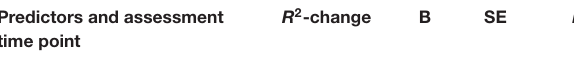
TABLE 4 | Results of the stepwise regressions of the motivation to change (ANSOCQ sum scores) with cognitive ED illness severity (ED-specific sum score of the EDI-2) over consecutive